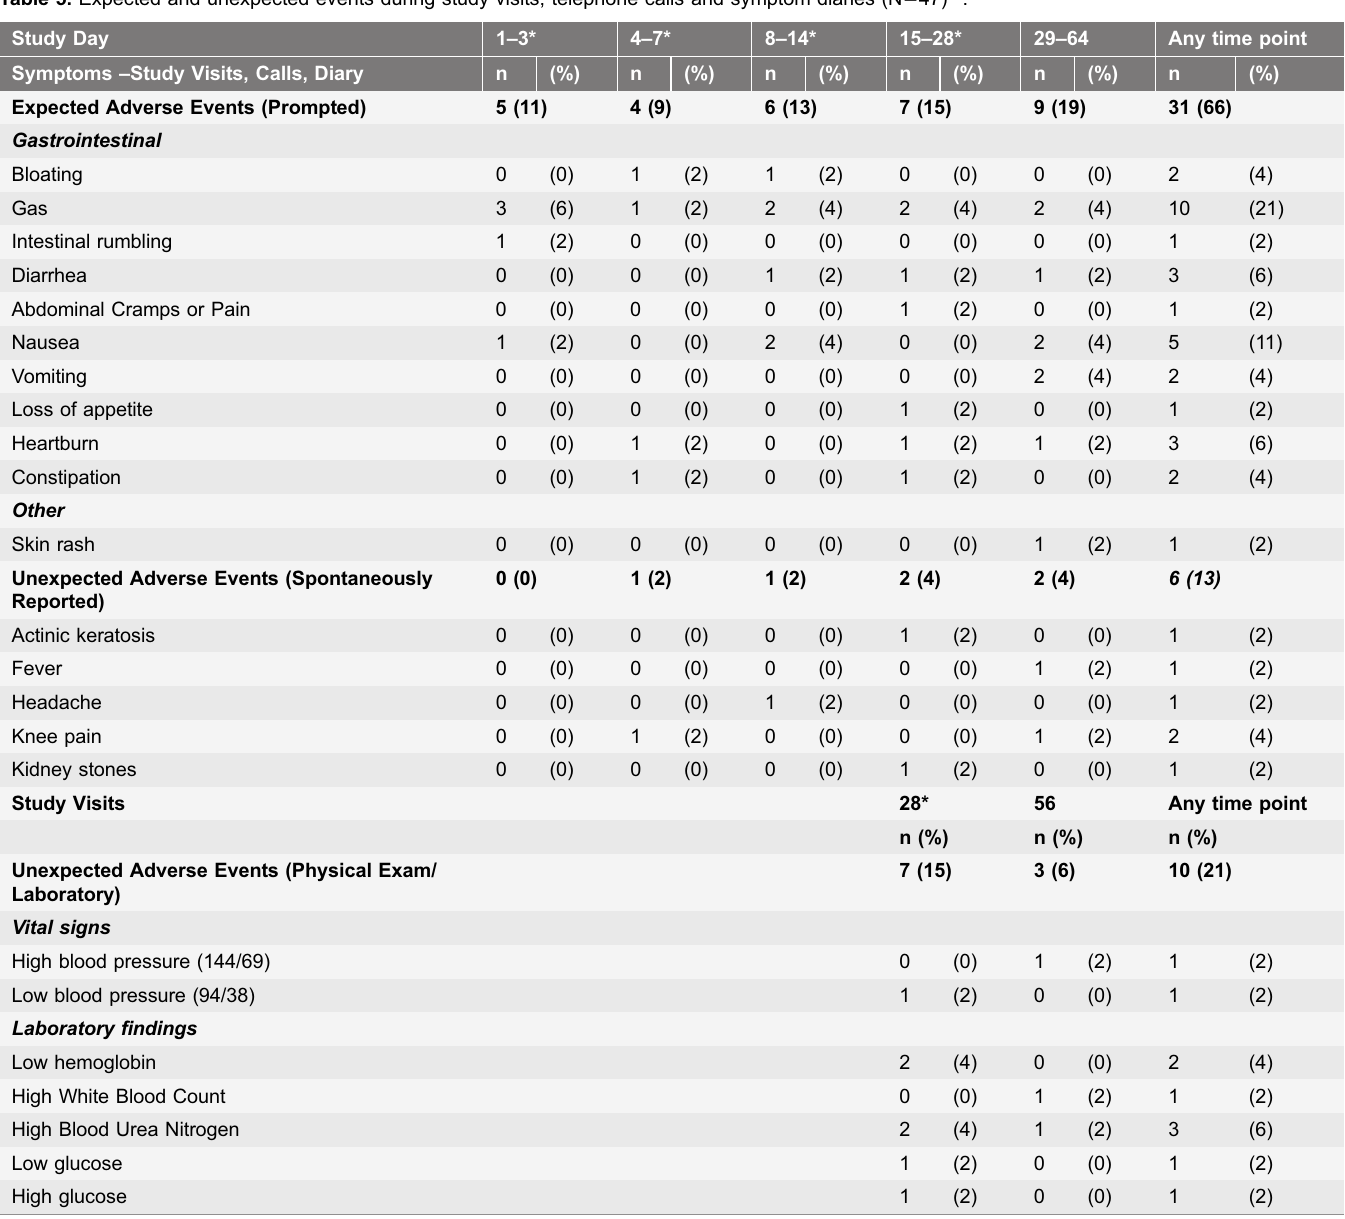
Table 5. Expected and unexpected events during study visits, telephone calls and symptom diaries (N 5